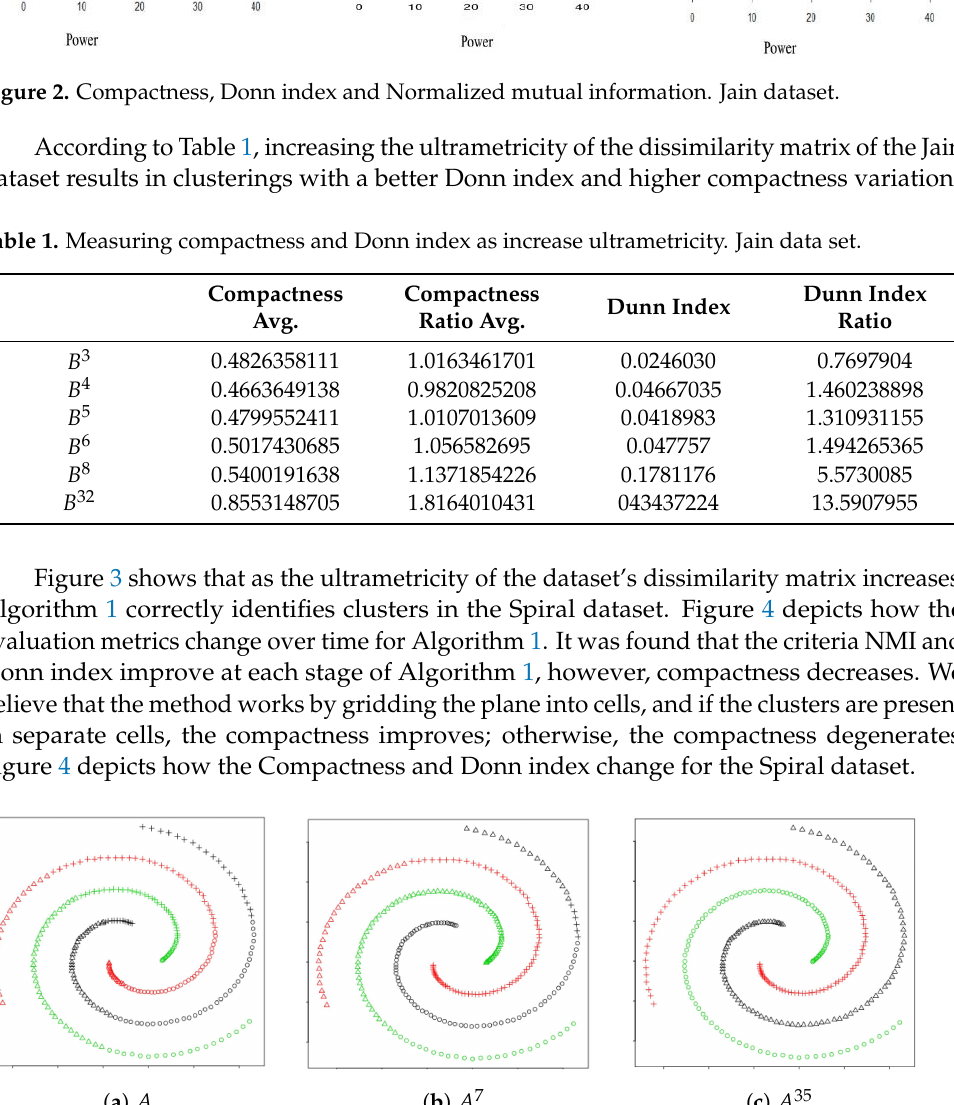
Table 1. Measuring compactness and Donn index as increase ultrametricity. Jain data set.